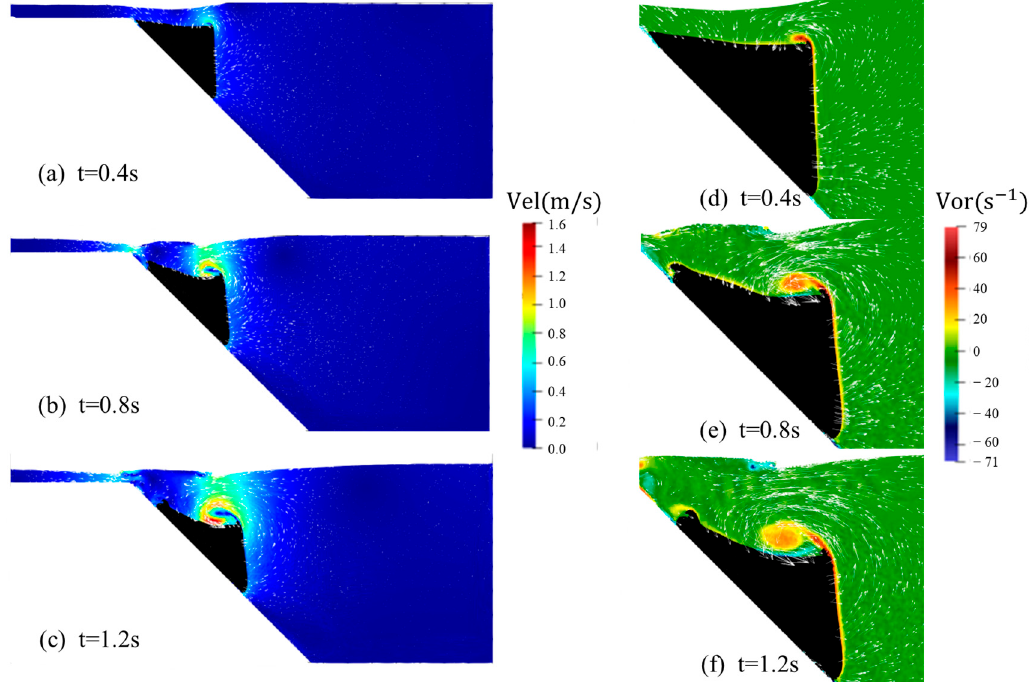
Figure 16. Evolution of the velocity and vorticity fields at typical instants. ( a ) velocity field at t = 0.4 s; ( b ) velocity field at t = 0.8 s; ( c ) velocity field at t = 1.2 s; ( d ) vorticity field at t = 0.4 s; ( e ) vorticity field at t = 0.8 s; ( f ) vorticity field at t = 1.2 s.